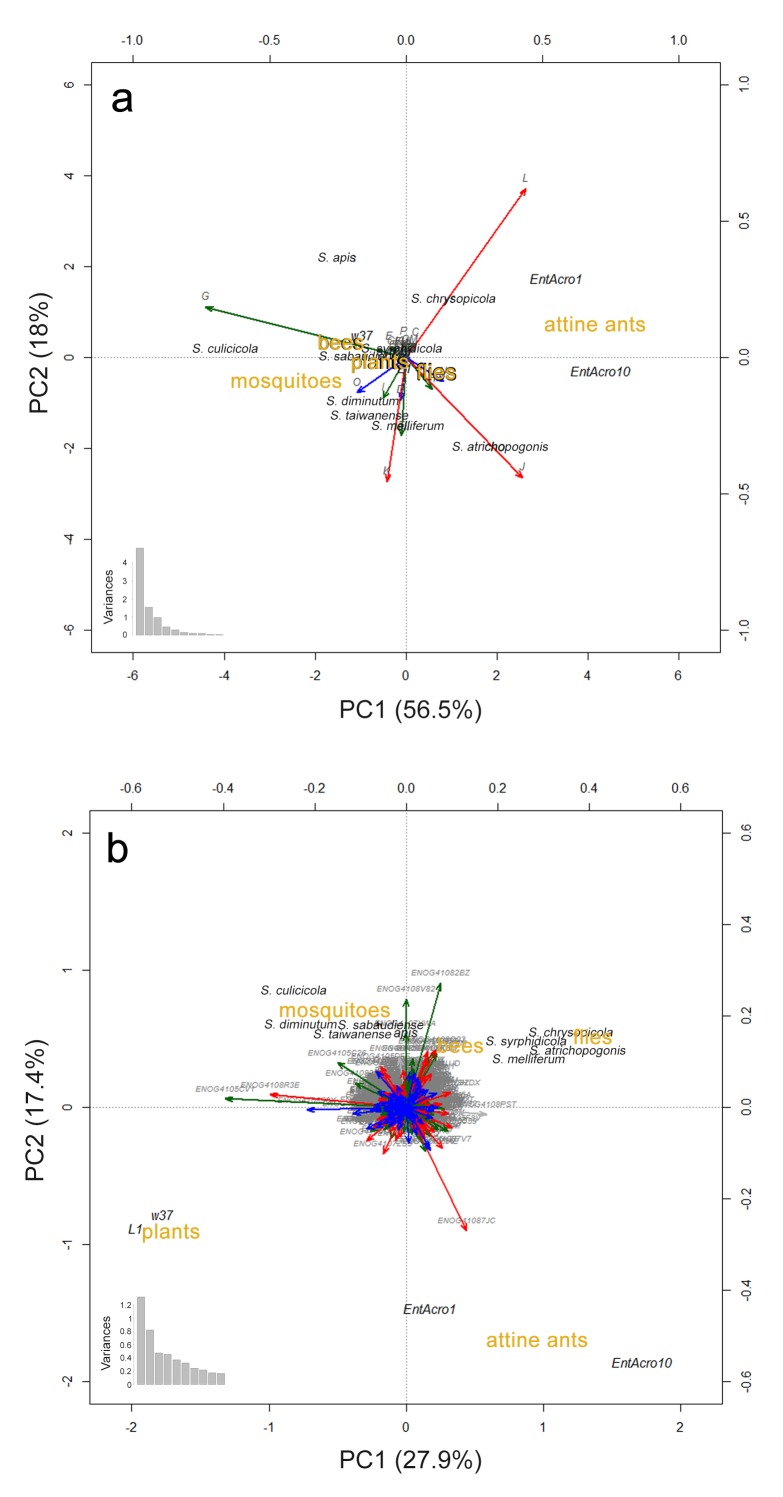
Principal Components Analyses (PCA) visualizing gene content similarities of EntAcro1, EntAcro10 and the eleven most closely related Mollicutes genomes.We used the same nine insect-associated Spiroplasma strains in all our comparative analyses (see Materials and methods) and two additional Mesoplasma strains (L1 and W37) which are the closest relatives of EntAcro1. We excluded the male-killing S. poulsonii strain from the comparisons because of its extreme (induced by a large number of transposases; see above and (Paredes et al., 2015)) genomic differences relative to the other Mollicutes strains, which masked the differences among the remaining strains. PCAs were based on proportional similarity in annotated genes across functional categories (A), and across orthogroups (B), as identified using the bactNOG database. The functional categories in (A) and the orthogroups in (B) are presented as vectors using the same color coding as in Figure 1—figure supplement 1. The distributions of variances among the vectors are given at the bottom left of each plot. Mollicutes strains are presented in black text, functional categories and orthogroups in grey text, and hosts of the Mollicutes strains in brown text. The plots do not include genes of unknown function (the S role category in Figure 1—figure supplement 1). In both the (A) and (B) panels segregation effects were primarily loaded by orthogroups related to metabolism and secondary by orthogroups related to information. In both analyses clustering of strains was more distinct when based on host similarities than on overall bacterial phylogenomic relationships.10.7554/eLife.39209.007Figure 1—figure supplement 3—source data 1.Functional annotation results for the 14 closely related insect-associated Mollicutes genomes using the bacterial eggnog (bactNOG) database.The proportional counts of genes (counts of each functional category or orthogroup divided by the total number of annotated genes) assigned to distinct functional categories via bactNOG are presented.